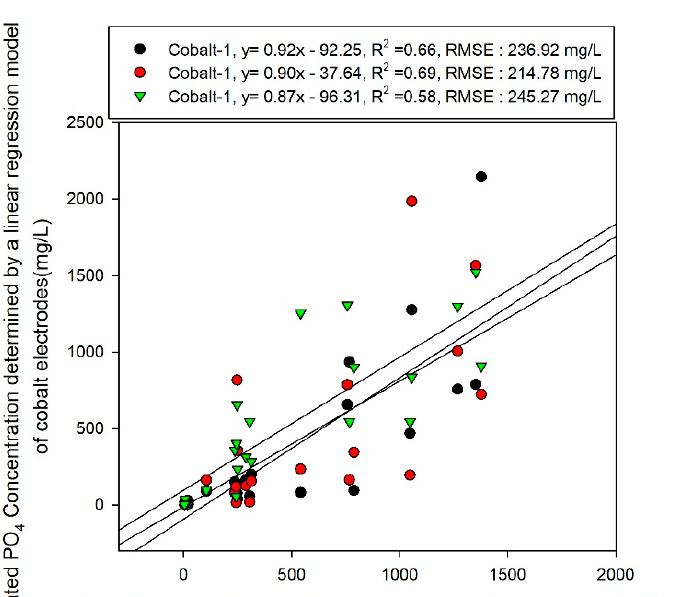
Figure 6. Test sample prediction results using the Nikolsky–Eisenman equation-based model with the electromotive force (EMF) response of cobalt electrodes.